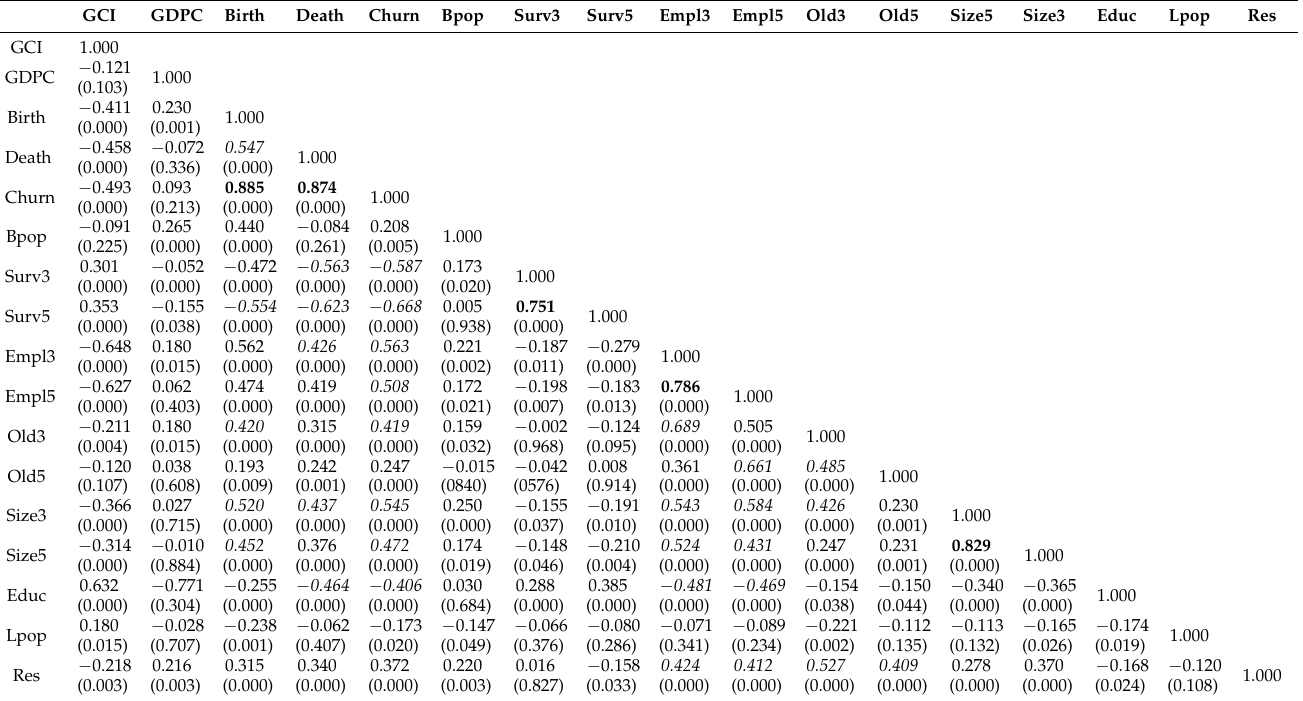
Table 4. Correlation